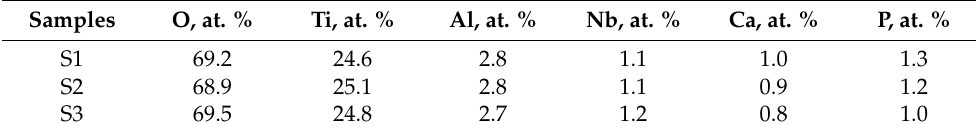
Table 3. EDS elemental analysis data for samples S1 – S3.